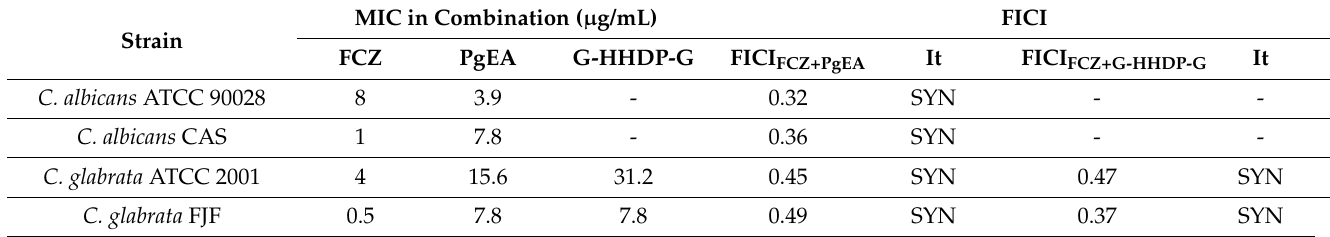
Figure 1. Interaction curves constructed for each pair of compounds when used in combination. Synergistic effect ethyl acetate fraction of P. granatum (PgEA) and fluconazole FCZ ( A – D ) against C. albicans ( A , B ) and C. glabrata ( C , D ) strains. Synergistic effect of galloyl-hexahydroxidifenoil-glucose (G-HHDP-G) and FCZ against C. glabrata strains ( E , F ). Table 5. FICI and classification of the interaction between PgEA or G-HHDP-G and FCZ. The interac- tion was classified as synergism if FICI ≤ 0.5, non-interaction if 0.5 > FICI ≤ 4.0, and antagonism if FICI >